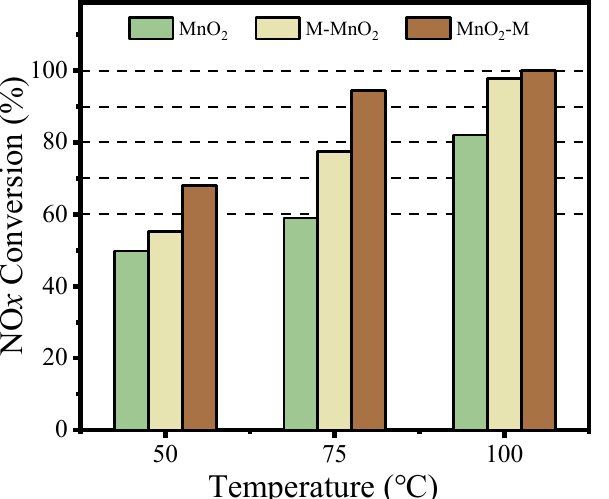
Figure 8. Comparison of NO x conversion of MnO 2 , MnO 2 -M, and M-MnO 2 catalysts at different temperature (reaction conditions: [NO] = 500 ppm, [NH 3 ] = 500 ppm, [O 2 ] = 5%, and N 2 as balance gas, GHSV = 40,000 h −1 ).